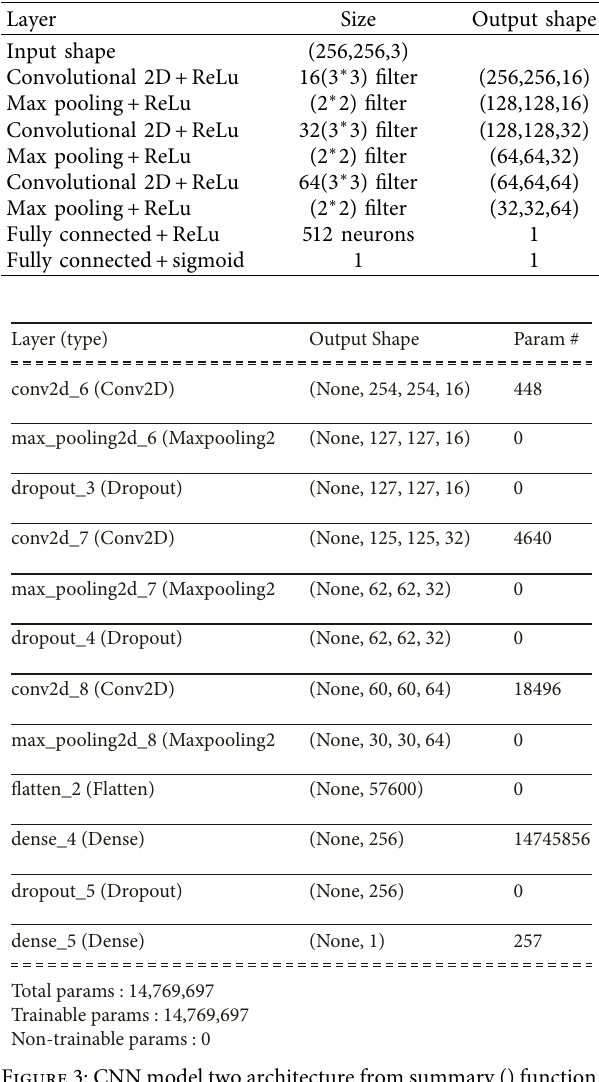
Figure 3: CNN model two architecture from summary ()